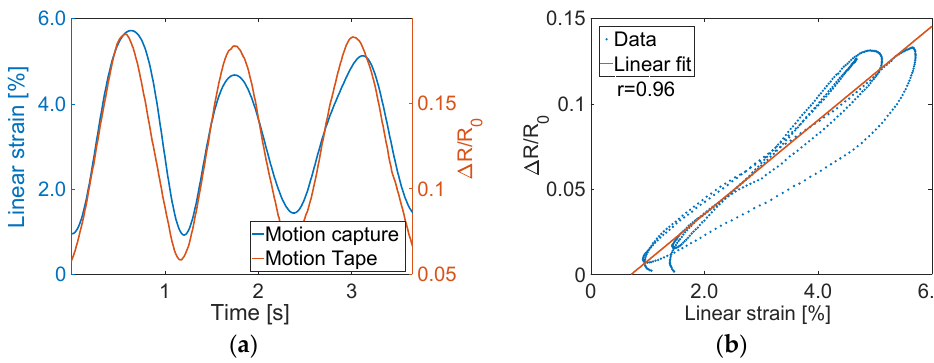
Figure 9. ( a ) The time history results for Motion Tape on the tibialis anterior are overlaid ( b ) with similar strain sensing properties observed with a tension similar to the compression case.